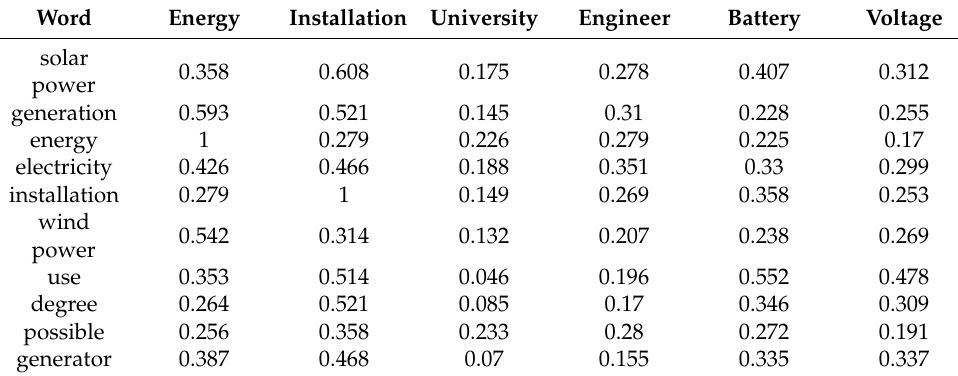
Table 5. Section of the matrix showing cosine similarity values between central words and the relevant words.